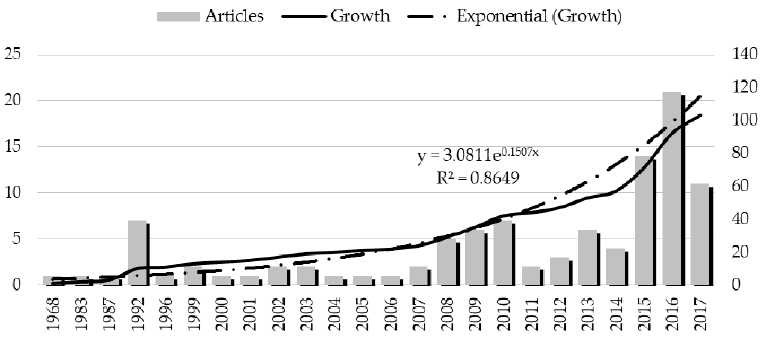
Figure 2. Annual number and growth of articles on Religious Tourism indexed in WoS. ( Source: Own elaboration).